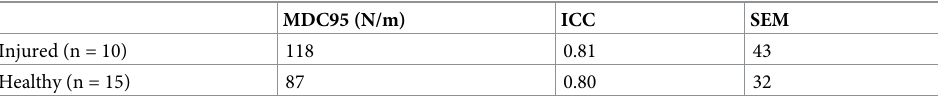
Table 2. Minimum detectable change with 95% confidence (MDC95), SEM (standard error of measurement) and intraclass correlation coefficient (ICC) of tendon